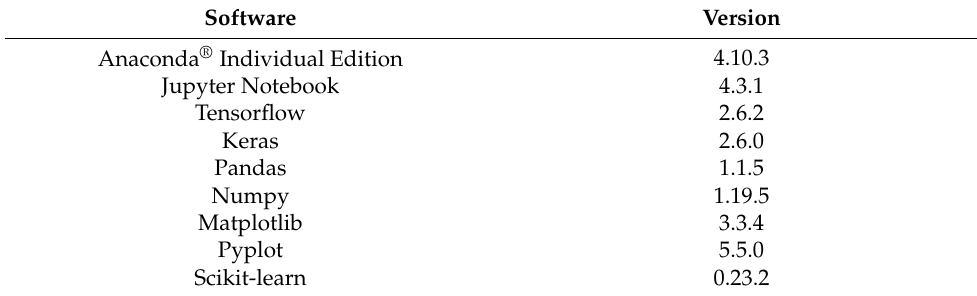
Table 2. Recipe of